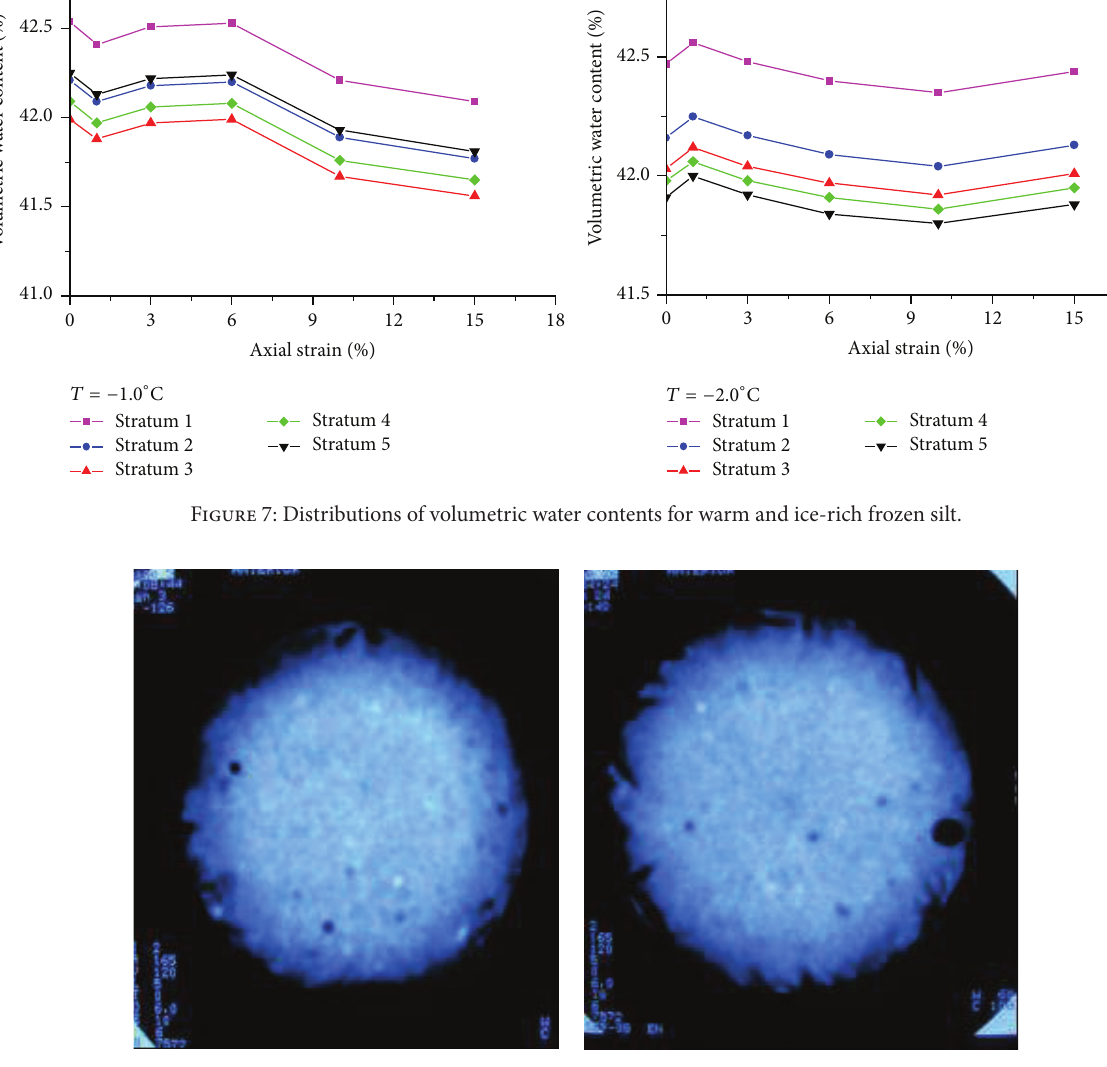
Figure 8: CT images with 𝜀 𝑎 = 0 and 𝜀 𝑎 = 15 % of warm and ice-rich frozen